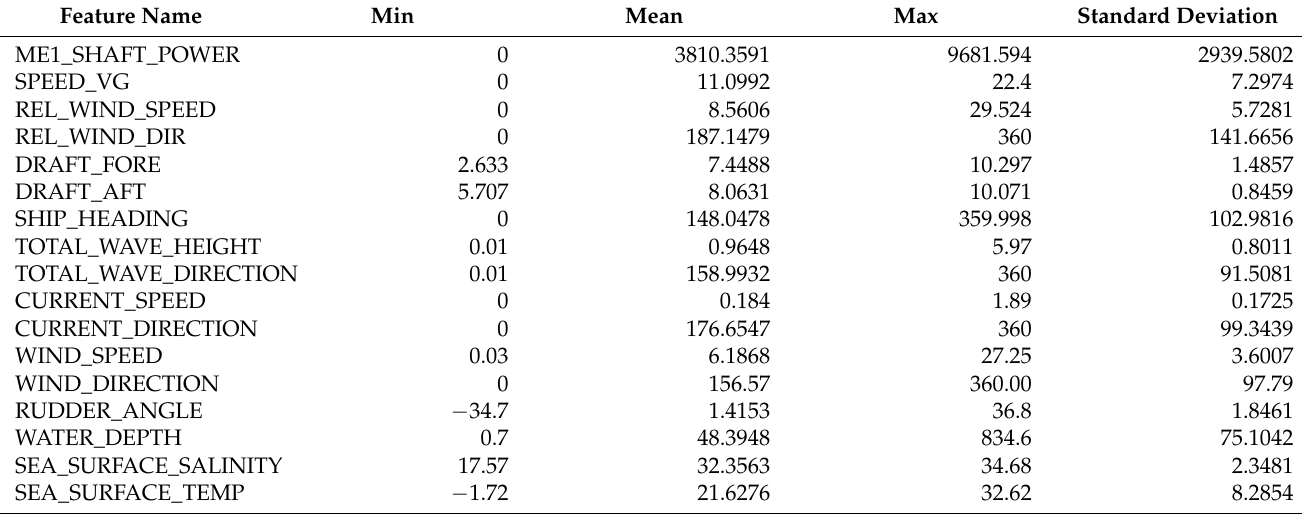
Table 5. Features the summary